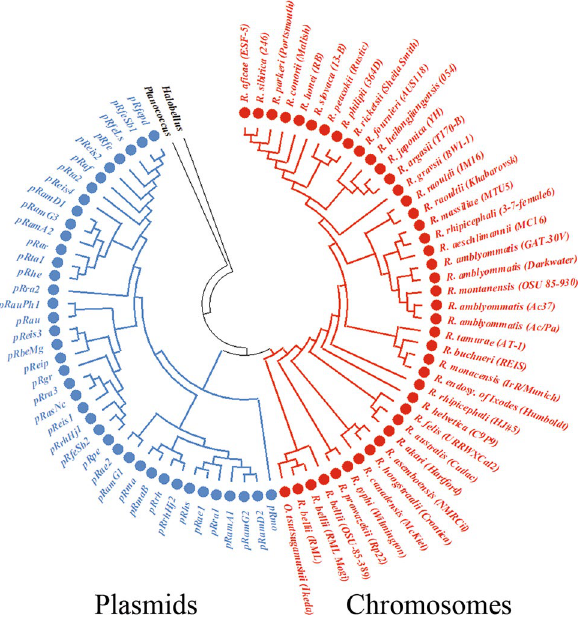
Figure 2. Supertree obtained from five genes of Rickettsia plasmids (n = 40) and chromosomes (n = 42) using the Robinson-Foulds algorithm (RF distance = 181). Orientia tsutsugamushi Ikeda (NC_010793.1), Planococcus antarcticus (ZP_10207867.1) and Halobellus rufus (WP_049986146.1) were used as best homologues to rickettsial genes. The list of genes used in the analysis includes dnaA-like replication initiator protein, helix-turn- helix DNA-binding domain, patatin-like phospholipase, cell surface antigen Sca12 and small heat shock protein (Supplementary Fig.